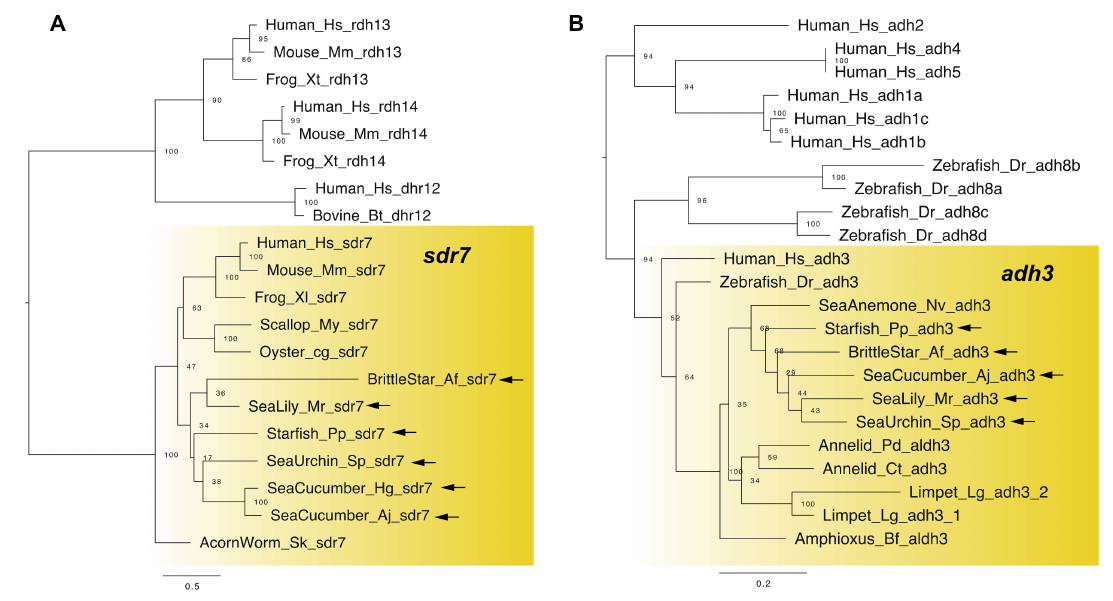
Figure 2. Maximum-likelihood phylogenetic tree for RDH genes ( A : sdr7 and B : adh3 ). All sequences are presented in Tables S1 and S2 and Supplementary Datasets 1 and 2. Sequences were aligned using the MAFFT v7 software with the default parameters [20]. Amino acid sites for tree construction were selected using the trimAl (1.2rev59) tool with a gap threshold of 0.8 [21]. A best-fitting amino acid substitution model and a maximum-likelihood tree were inferred using the RaxML v8.2.12 soft- ware [22]. Confidence values shown at nodes were calculated after 1000 bootstrap runs. Yellow box and arrows, respectively, indicate sdr7 ( A ), adh3 ( B ) gene clade and the genes retrieved from dataset of echinoderms. Abbreviation: Human; Homo sapiens , Mouse; Mus musculus , Bovine; Bos taurus , Frog; Xenopus tropicalis , Frog; Xenopus leavis , Zebrafish; Danio rerio , Amphioxus; Branchiostoma floridae , Acorn worm; Saccoglossus kowalevskii , Sea cucumber; Holothuria glaberrima , Scallop; Mizuhopecten yessoensis , Oyster; Crassostrea gigas , Annelid; Platynereis dumerilii , Annelid; Capitella teleta , Limpet; Lottia gigantea and Sea anemone; Nematostella vectensis